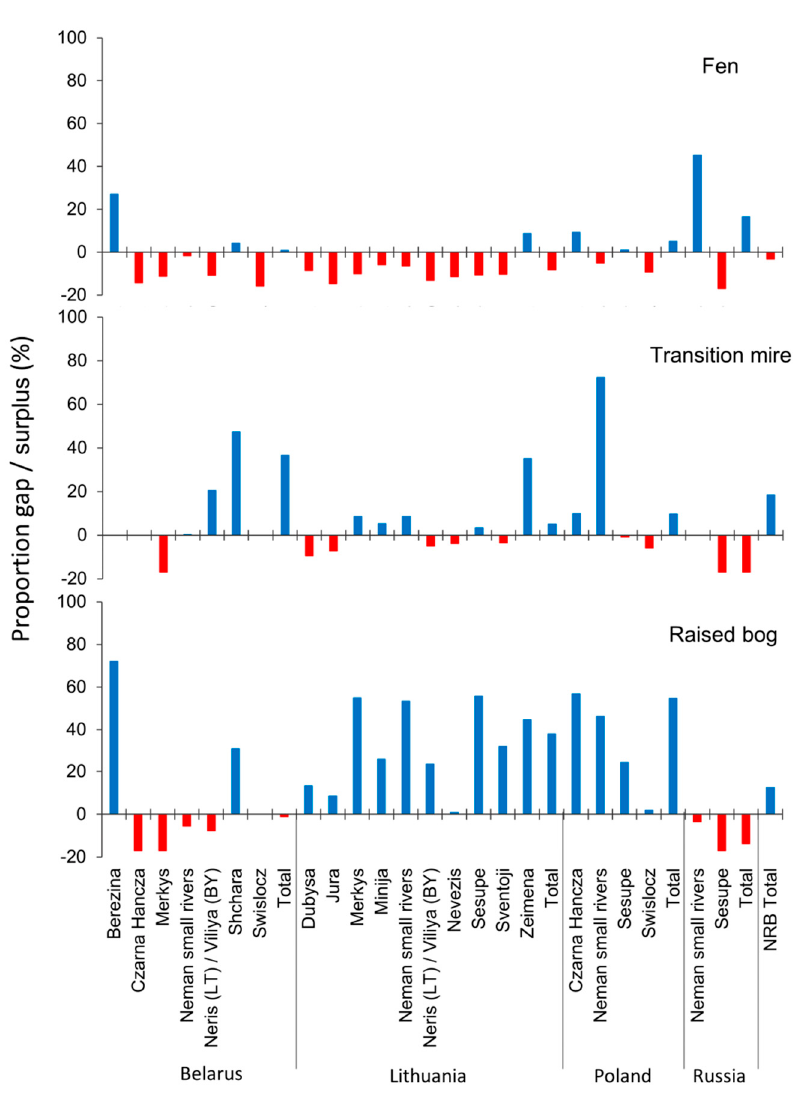
Figure 6. Protection gaps and surpluses of peatlands that are protected and have no drainage as a proxy for peatland quality, for each country and sub-river basins of the Neman River basin. In addition, the overall protection gap/surpluses are contained in the NRB Total. Values equalling more than zero indicate a protection surplus in area proportion, values below zero indicate a gap in the protection of peatlands base on the Convention of Biological Diversity target #11 (17% protection).